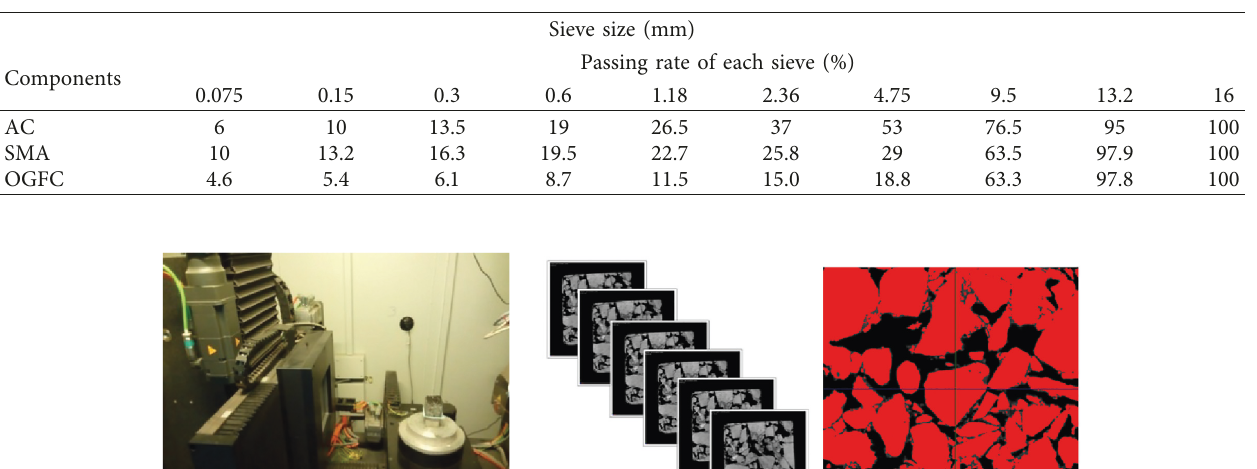
Figure 1: 3-D model of inflatable patterned tire. Table 1: Design gradation of asphalt mixtures.